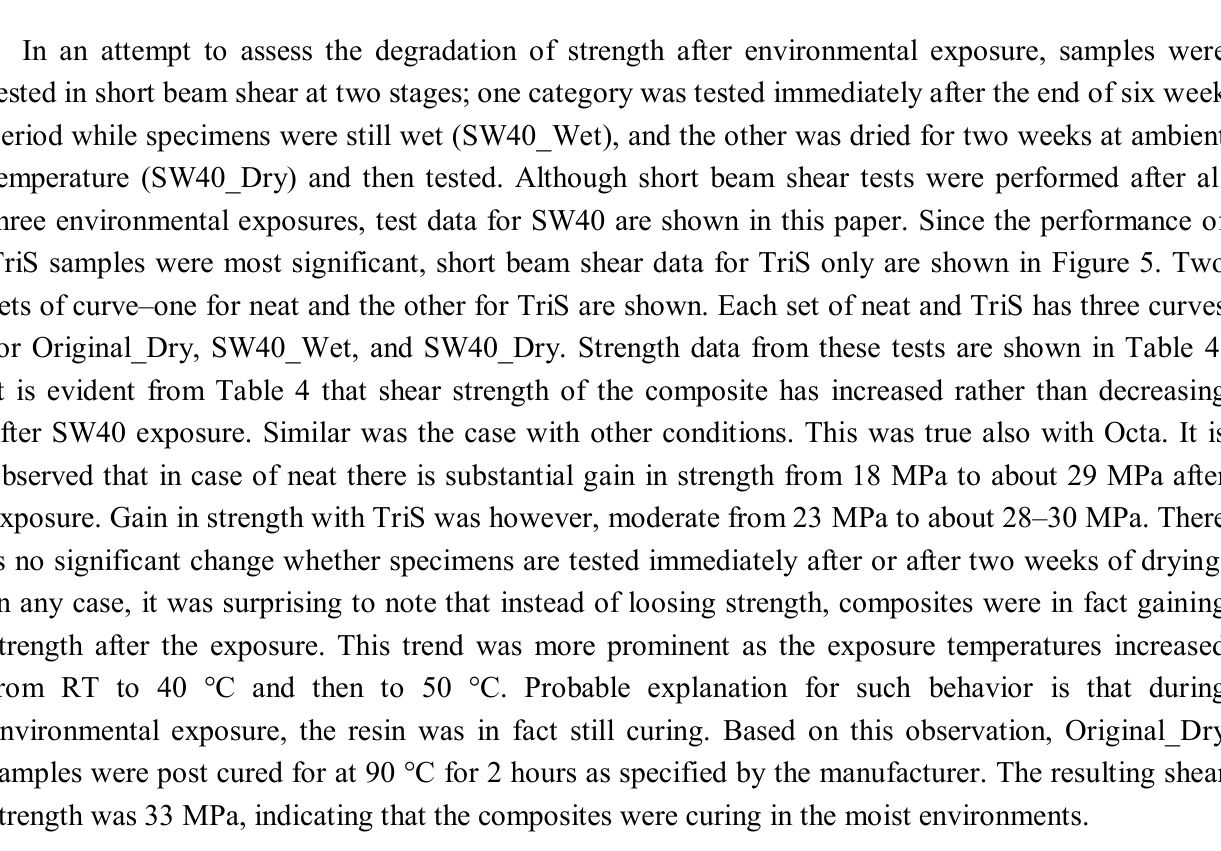
Figure 5. Seawater 40 °C short beam shear testing results.